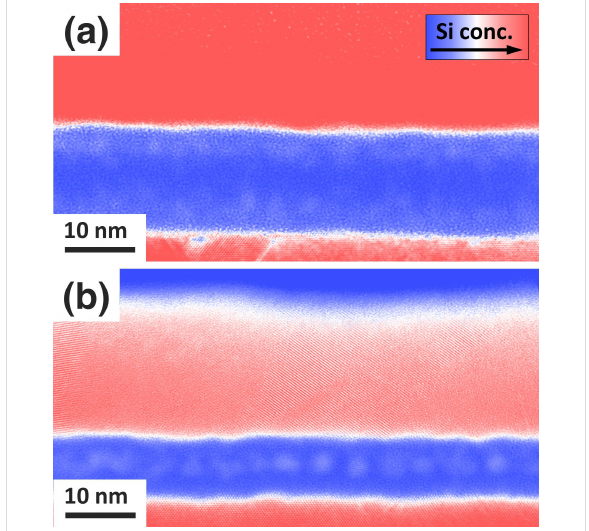
Figure 1: Cross-sectional Si plasmon-loss TEM images showing the Si NC formation in buried SiO 2 layers of (a) 14 nm (mixing: 100 Si + nm − 2 , 50 keV; thermal treatment: 1298 K for 30 s) and (b) 7 nm (mixing: 170 Si + nm − 2 , 60 keV; thermal treatment: 1323 K for 120 s) thickness. Here, red color corresponds to a high Si plasmon peak intensity, white to an intermediate intensity, and blue to the absence of a Si plasmon signal. While two layers of NCs form in the case of the 14 nm thick SiO 2 layer only one layer forms when the SiO 2 thickness is 7